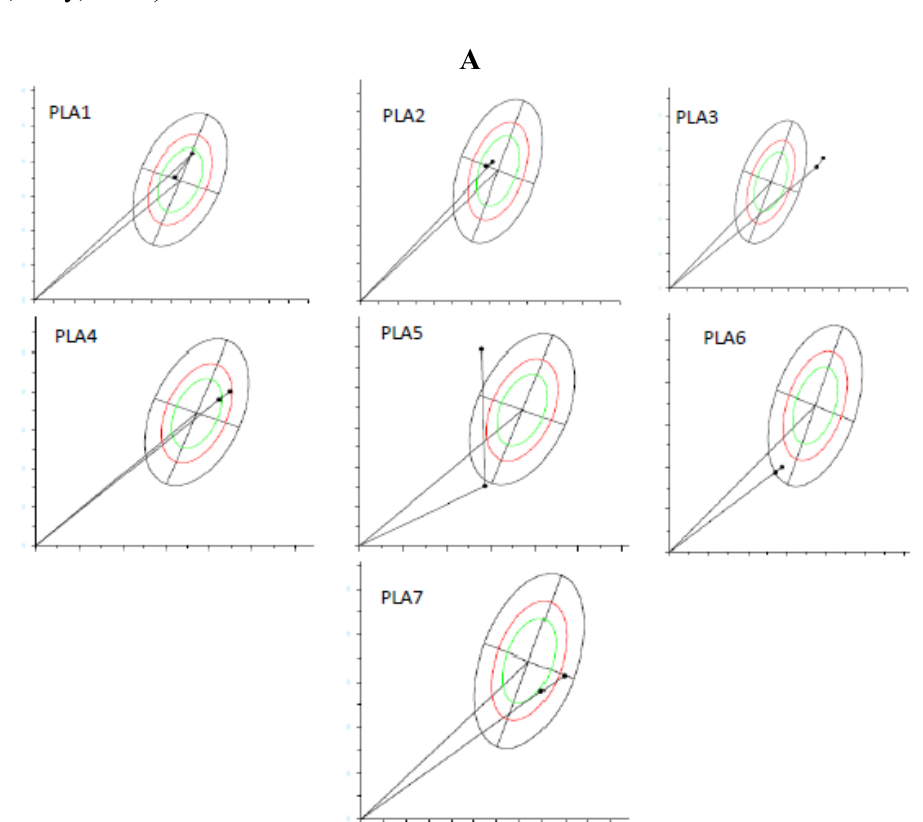
Figure 2. R/Xc path graph of vector migration. ( A ) PLA group ( n = 7) and ( B ) SYN group ( n = 8). The vectors were plotted on the reference 50th, 75th, and 95th tolerance ellipses of a reference healthy population. The path graph starts with an arrow from the origin ((0.0) point in the graph). When observing the arrow, the first point is the initial value and the second is the final value. To understand the meaning of vector migration, the major axis refers to hydration status (dehydrated individuals tending towards the upper